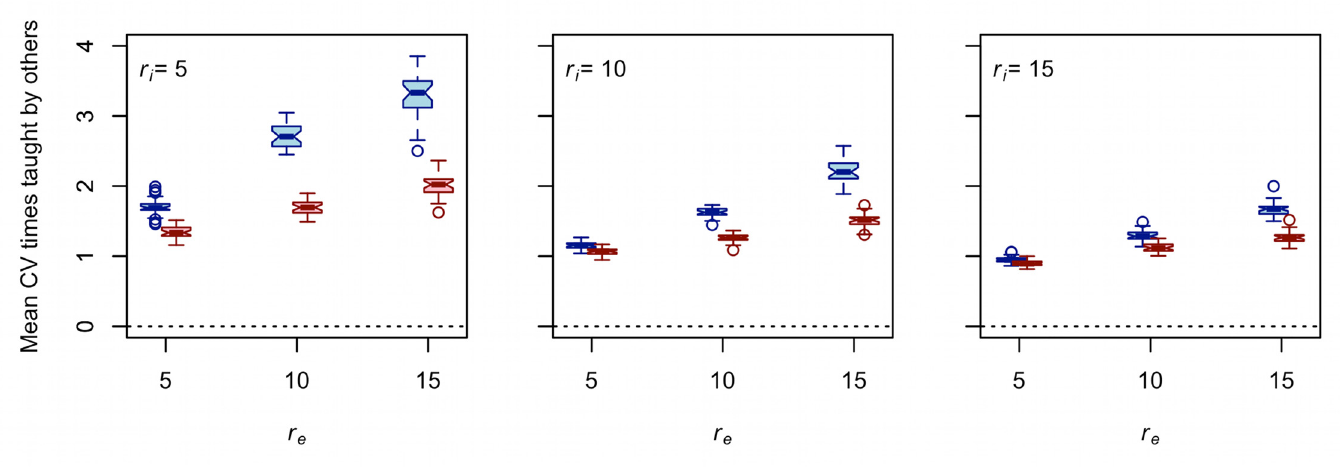
Fig 5. Increasing r e increases the mean CV of times taught by each of the other 24 groups for both trait A (blue) and trait B (red). Each boxplot represents 30 unique simulation runs. The length of the interaction radius increases from the left panel to the right panel. The dotted line provides the expected value in an idealized Wright-Fisher population (i.e., random copying). Note that d = 0.75 and that these results are exactly the same for all values of μ